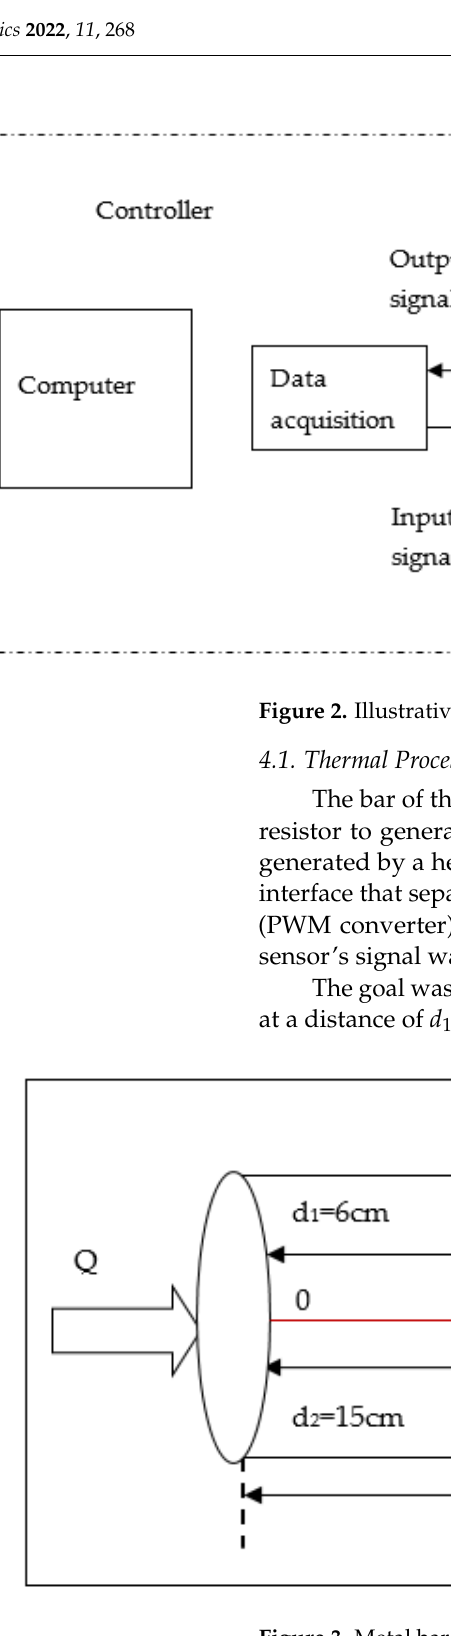
Figure 3. Metal bar connected with two sensors.